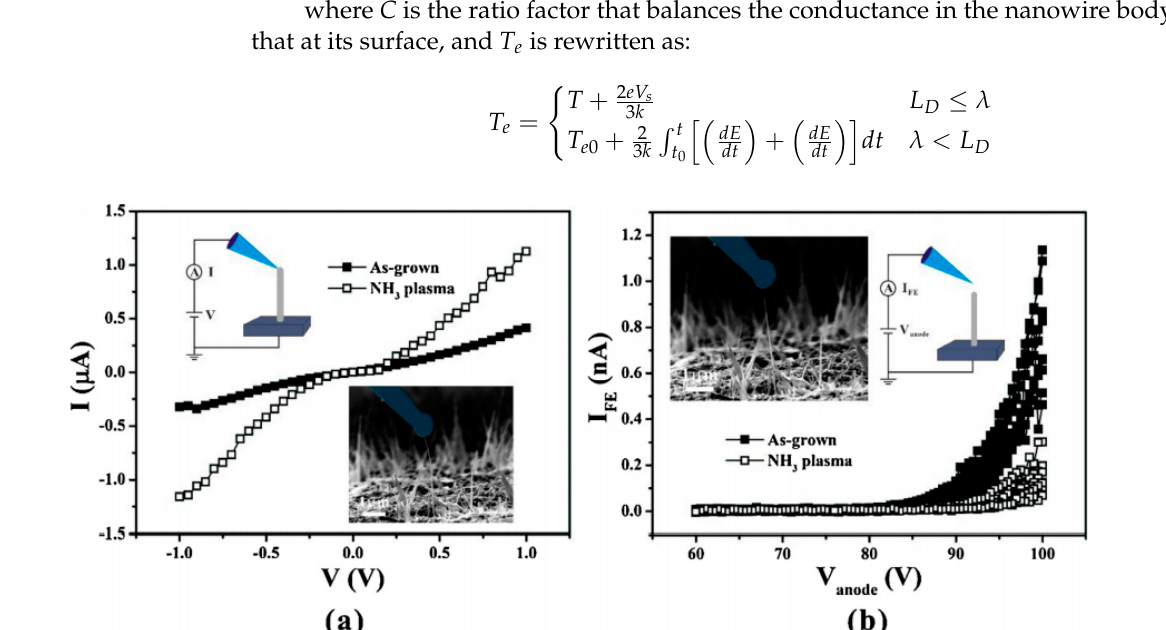
Figure 16. The electrical ( a ) and field emission ( b ) characteristics of an individual ZnO nanowire before and after the NH 3 plasma treatment. Reproduced from [81], with the permission of Elsevier, 2018.